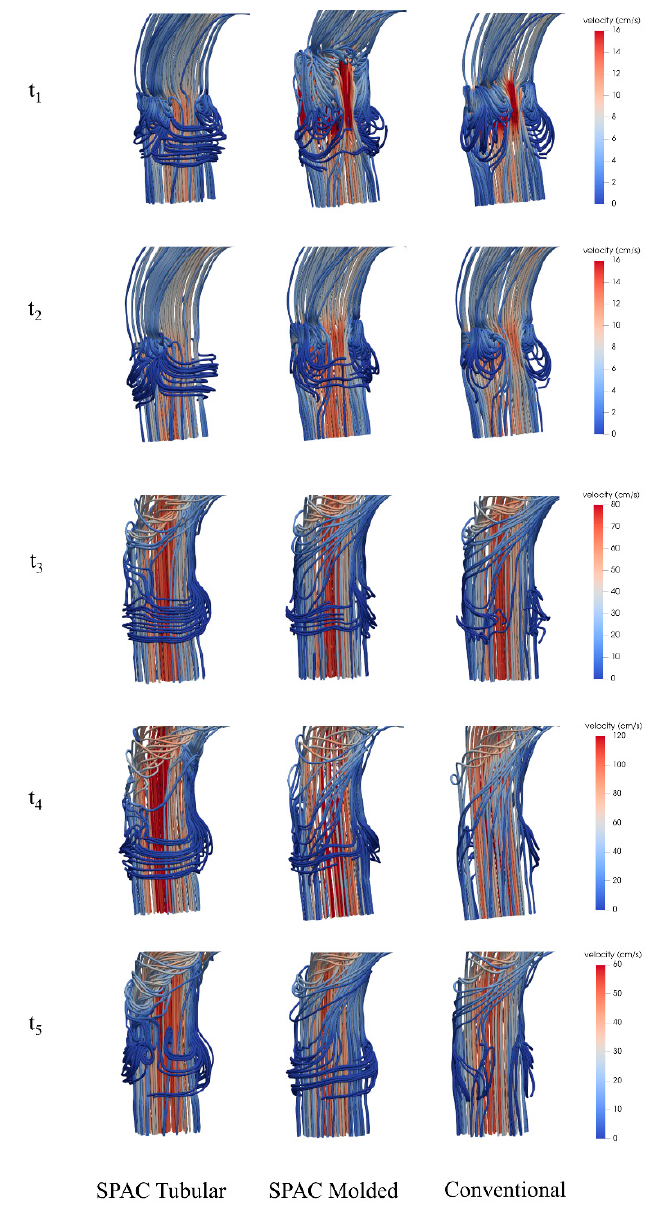
Figure 6. The streamline distribution in aortic root at different time points.